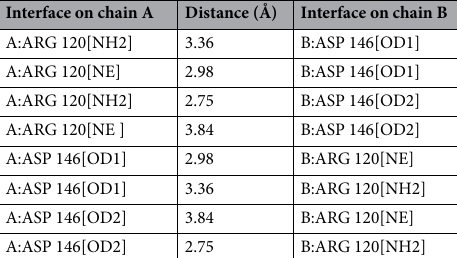
Table 4. Salt bridge interactions at the dimer interface.